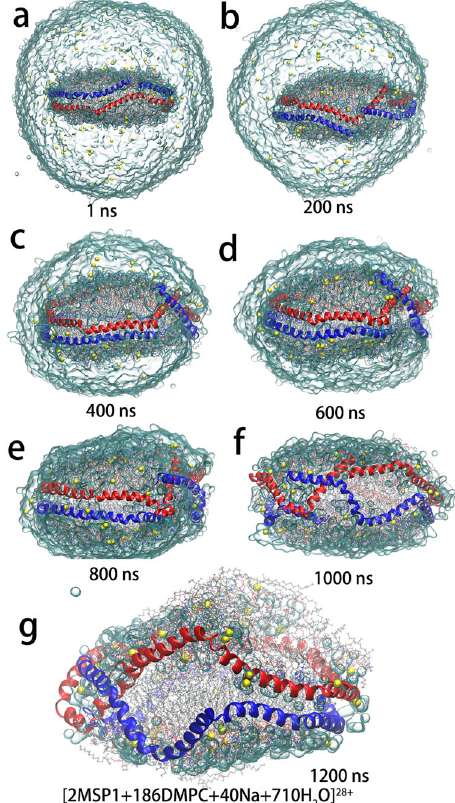
Fig. 2 Evolution of the charged nanodisc droplet in the off-center scenario. a – i The snapshots at different simulation times in the 300-1 simulation. The representation is the same as in Fig.